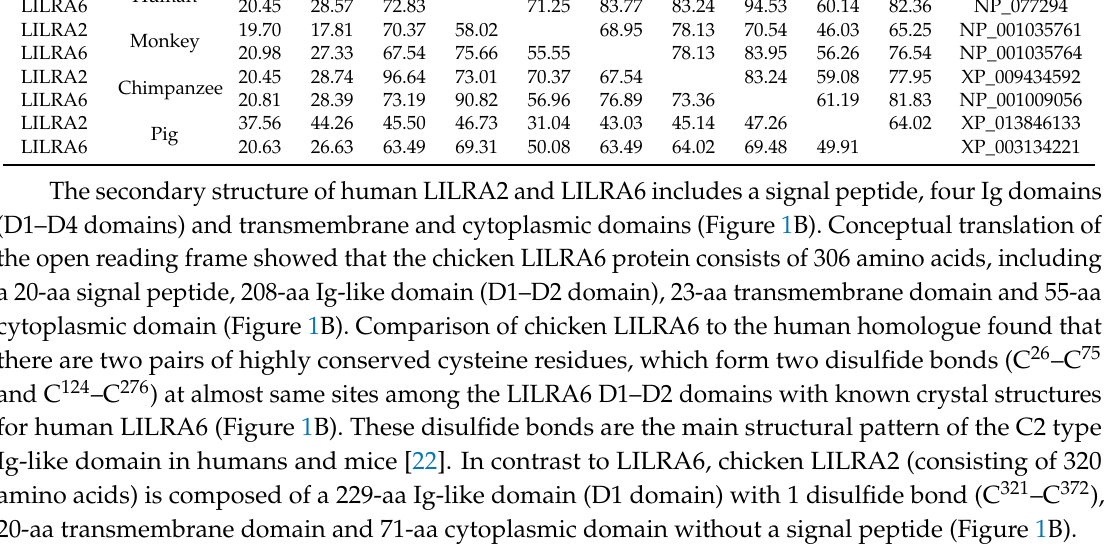
Table 1. Similarities (upper) and identities (below) of chicken LILRA2 and LILRA6 to homologues of other species. LILRA2LILRA6LILRA2LILRA6LILRA2LILRA6LILRA2LILRA6LILRA2LILRA6 GenBank Acc Genes Species Chicken Human Monkey Chimpanzee Pig